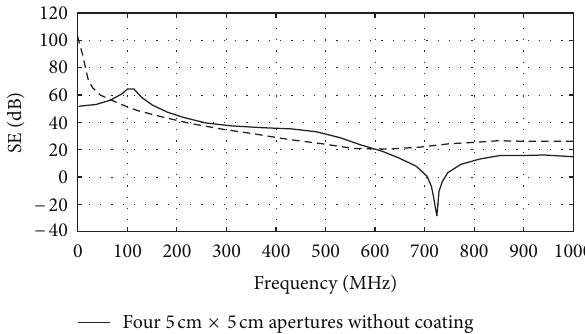
F 17: Frequency response of the band-stop �lter composed of planner array of strips.